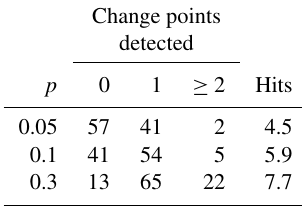
Table 1. Percentages of total numbers of change points detected by SRSD ( p , 30, 2) in each series on average and hits of the true = (1 , 2). change point c 1 = 51. The regime variances are σ 2 j Change